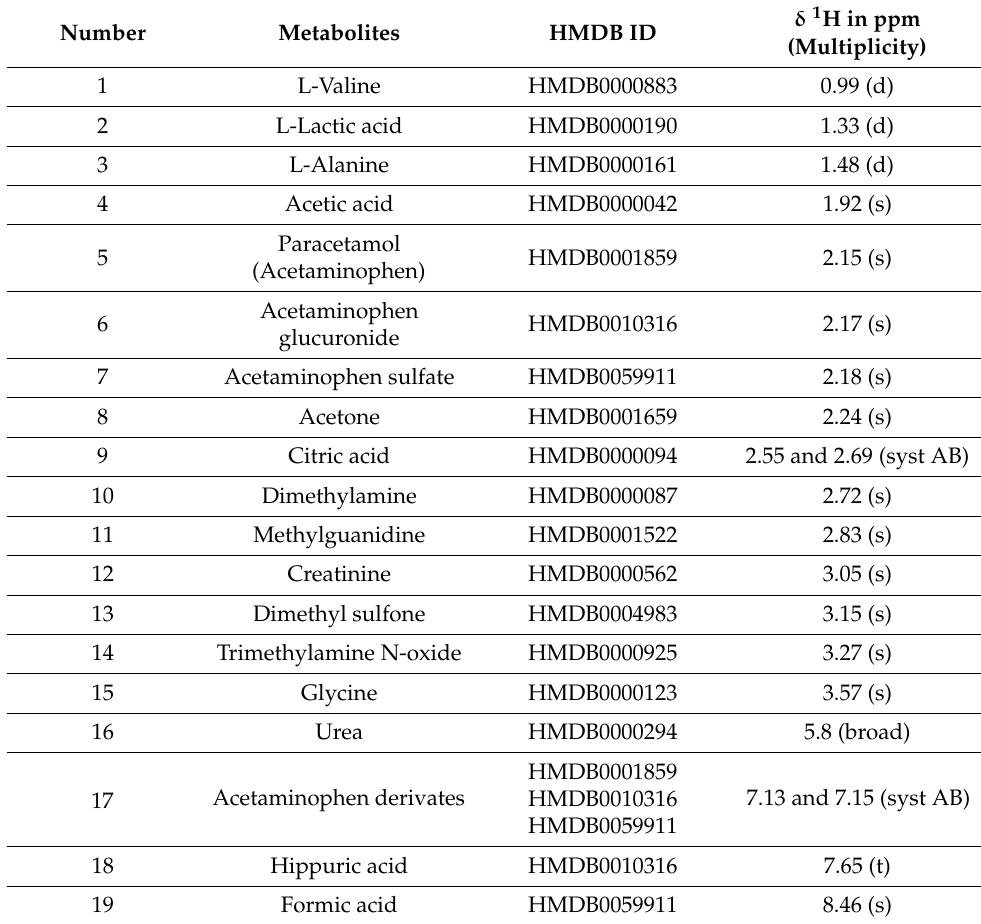
Table 2. NMR chemical shift ( δ ) and Human Metabolome Database identification number (HMDB ID) for selected